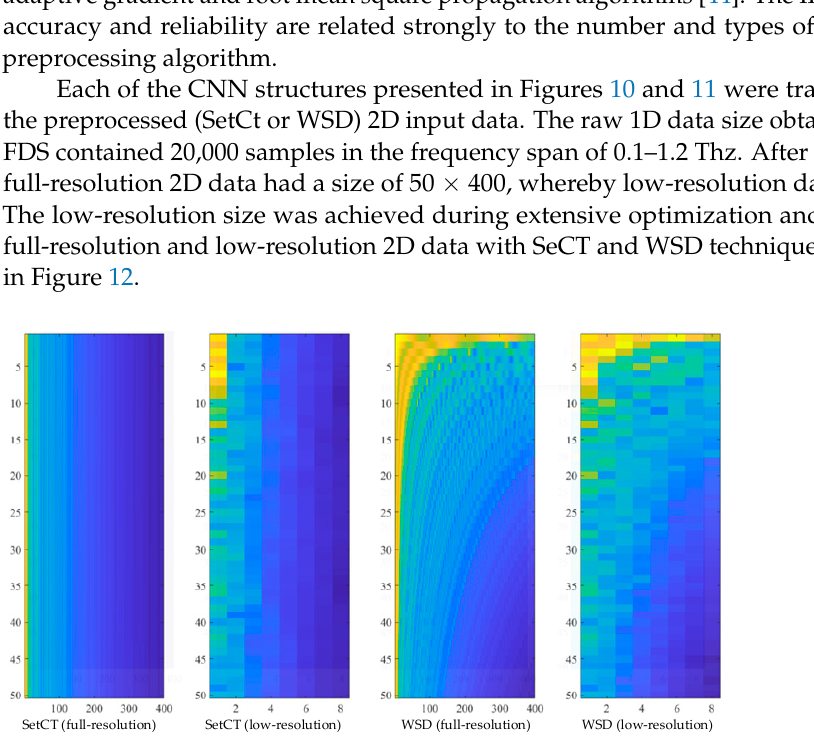
Figure 12. SetCT and WSD 2D transformation.